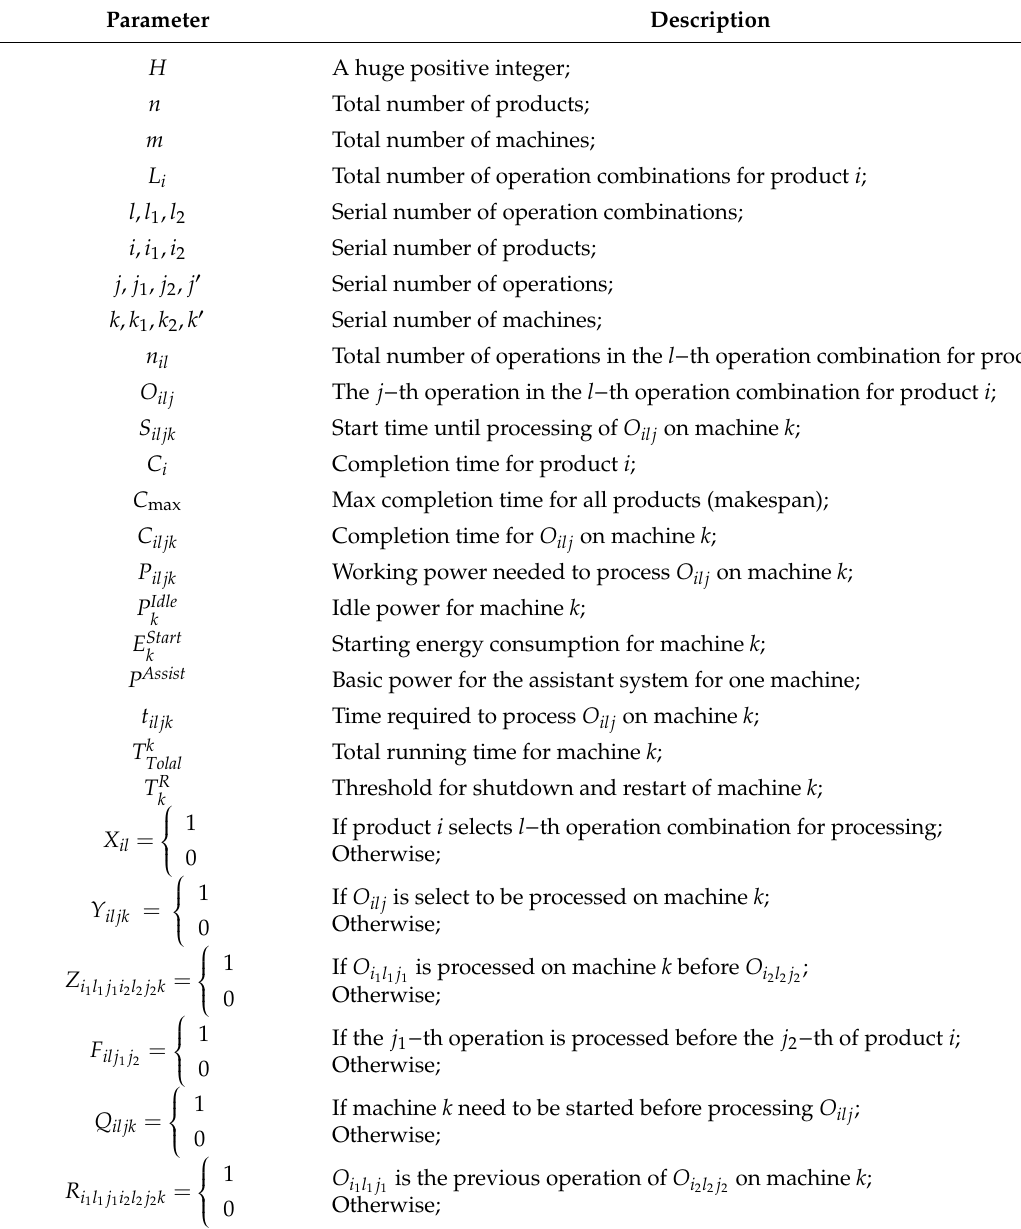
Table 3. The relevant parameters for the multi-objective IPPS